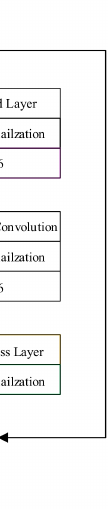
Figure 3. Configuration of the bottleneck residual